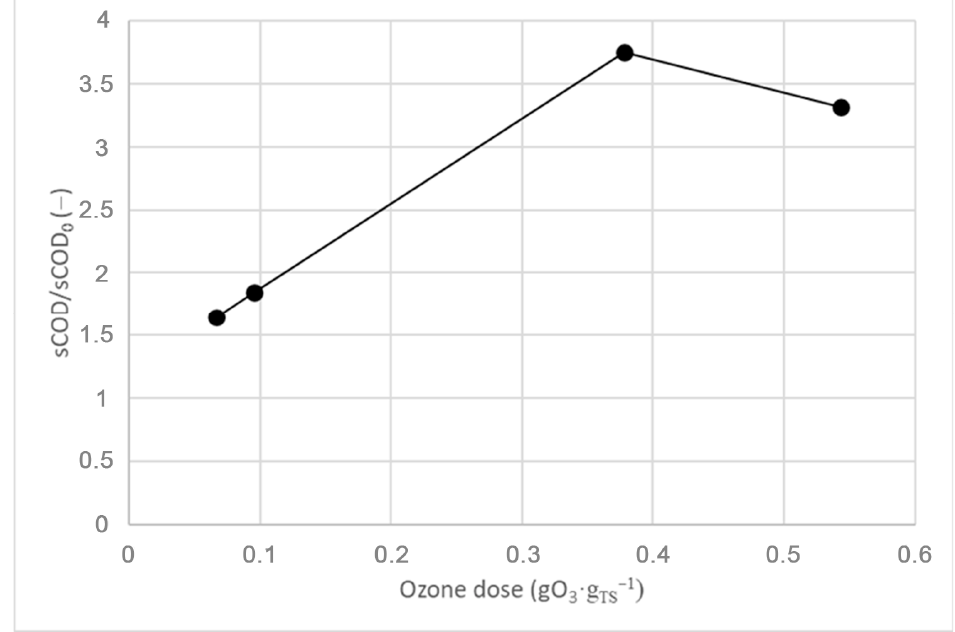
Figure 2. Soluble COD changes after the application of different ozone